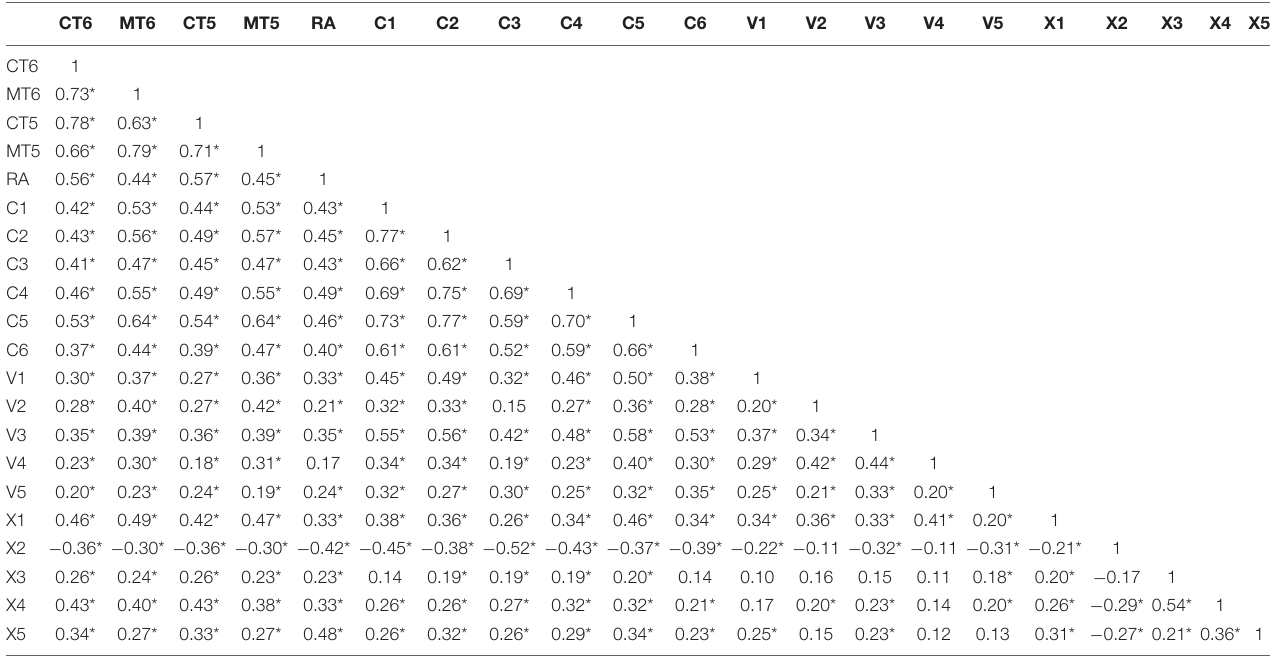
TABLE 2 | Correlations of all measures.